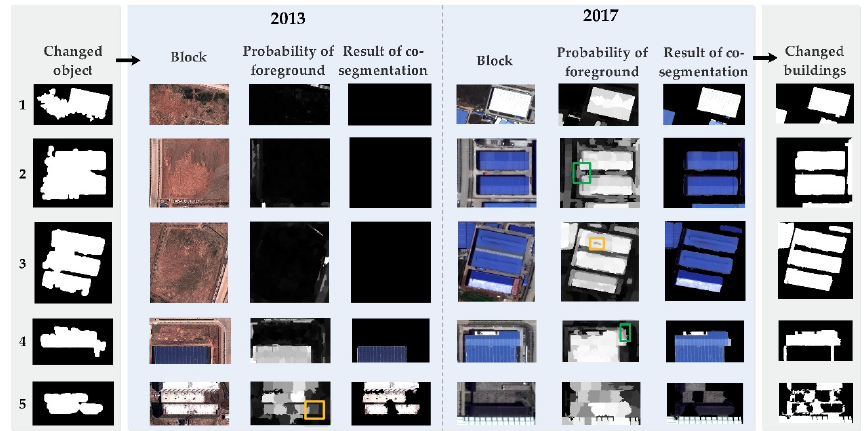
Figure 7. Co-segmentation results of some blocks.